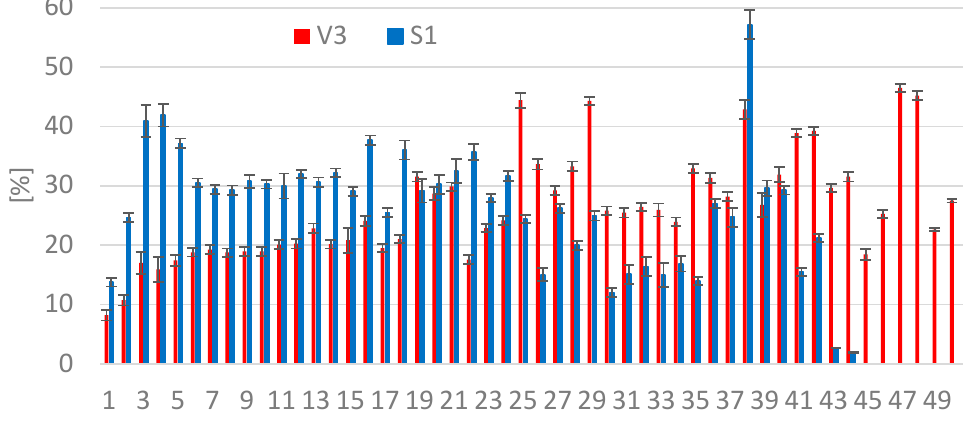
Figure 2. Moisture Values for Samples from Core Boreholes V3 and S1.